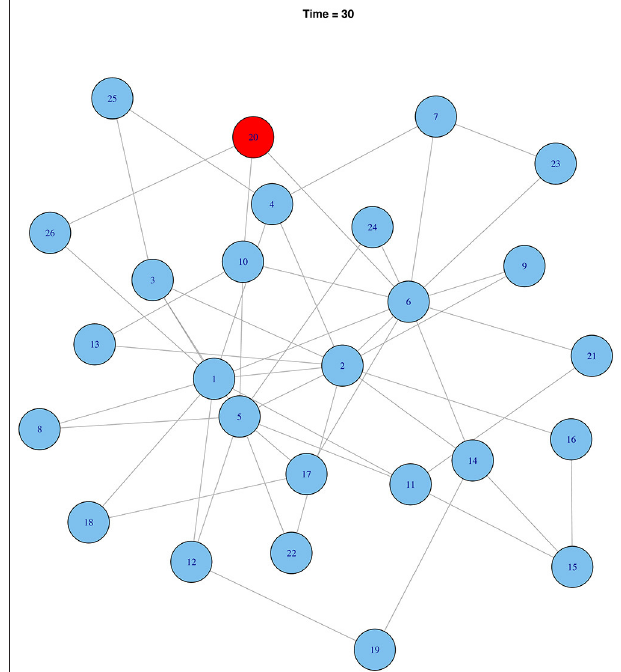
FIGURE 9 | Effect of controlling rHAT when using effective control methods after 30-time steps. Infected nodes are shown in red and uninfected in blue.